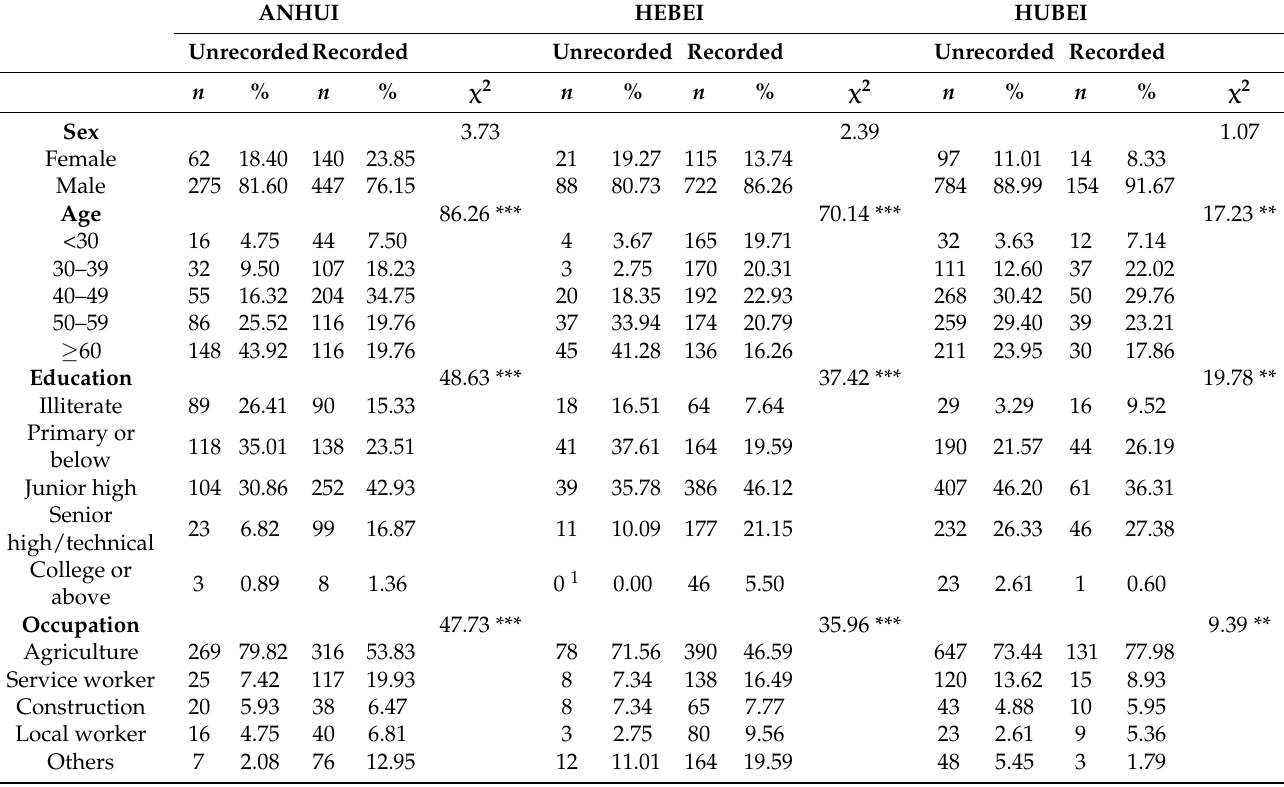
Table 1. Demographic characteristics of unrecorded and recorded bai jiu drinkers.